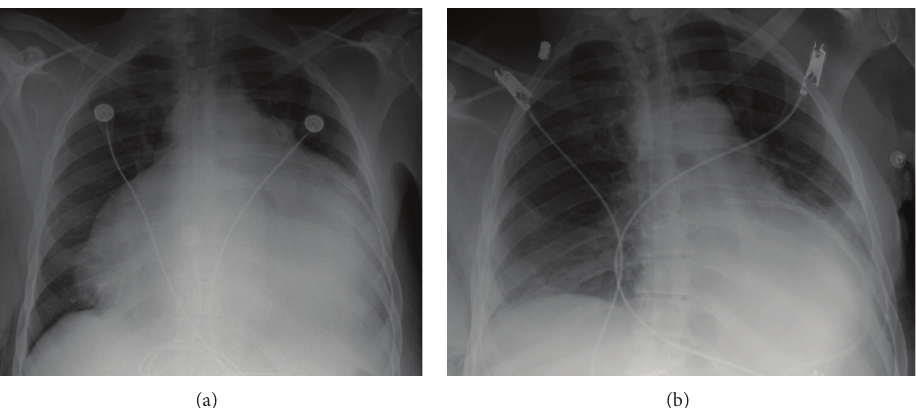
Figure 1: CXR. (a) Classical “water bottle” shaped cardiomegaly due to pericardial fluid. (b) Resolution of cardiomegaly after pericardial fluid drainage.